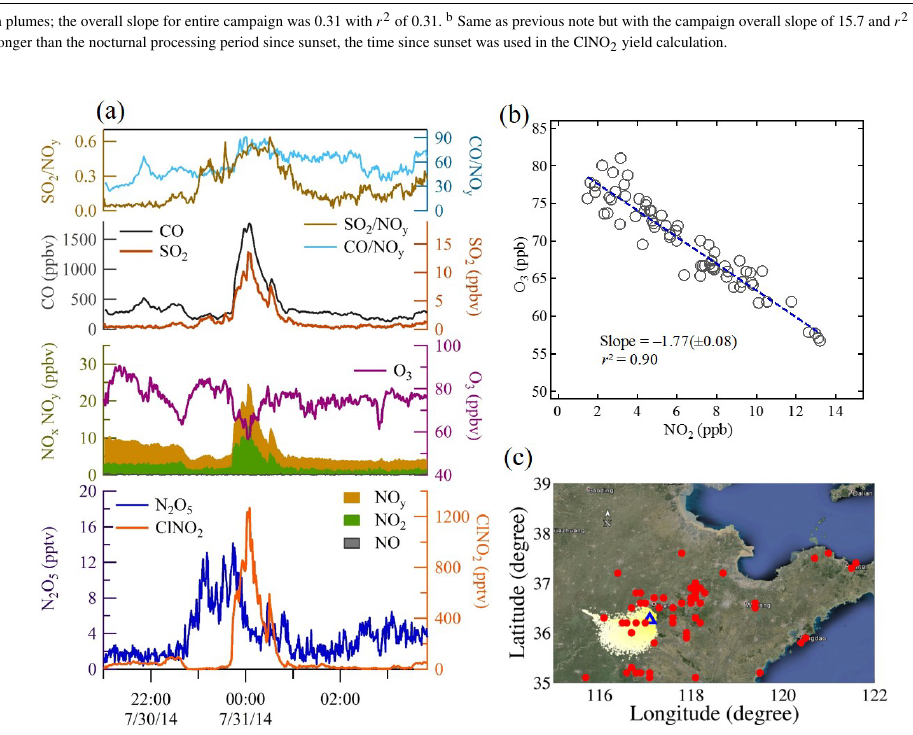
Figure 4. (a) Time series for ClNO 2 , N 2 O 5 , and related trace gases observed within the high-ClNO 2 plume from power plants and industry during the night of 30–31 July 2014. (b) Plot of O 3 vs. NO 2 concentrations for the plume; plume age was determined from the plot using Eq. (2). (c) 12h HYSPLIT backward particle dispersion image depicting air masses arriving at the measurement site (blue triangle) at the time of the plume, and red dots indicating the location of major coal-fired facilities in cement and steel production and power plants in the